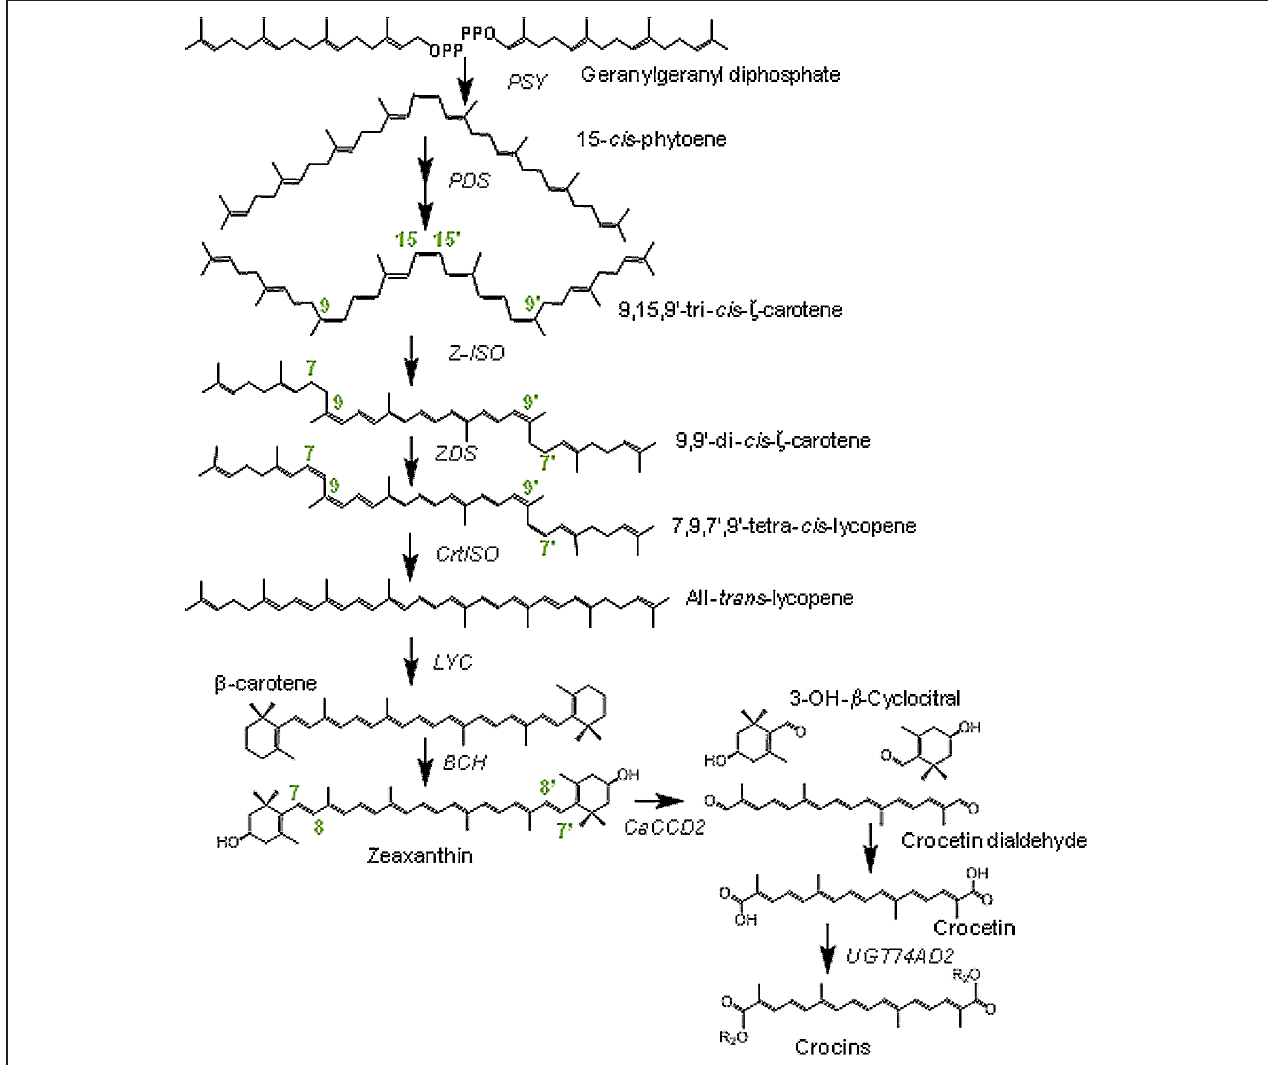
FIGURE 1 | Biosynthetic pathway for crocins in Crocus ancyrensis stigmas and tepals. PDS, phytoene desaturase; PSY, phytoene synthase; Z-ISO,15- cis - ζ -carotene isomerase; ZDS, ζ -carotene desaturase; CtrISO, carotene isomerase; LCY, lycopene β -cyclase; BCH, β -carotene hydroxylase enzymes; CaCCD2, carotenoid cleavage dioxygenase 2 from C. ancyrensis .